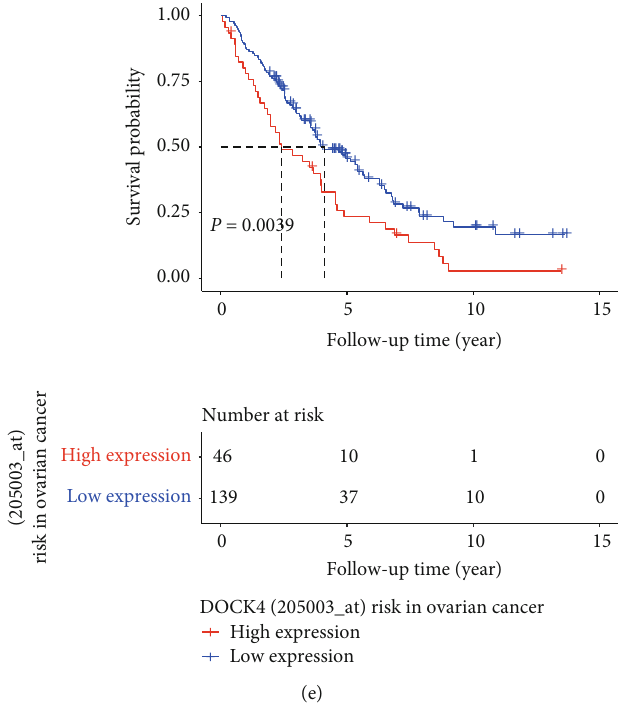
Figure 2: The prognostic value of DOCK4 in OV. Kaplan-Meier curves show the association between DOCK4 expression and overall survival, using data from (a) TCGA, (b, c) Kaplan-Meier plotter, and (d, e) GEO in ovarian